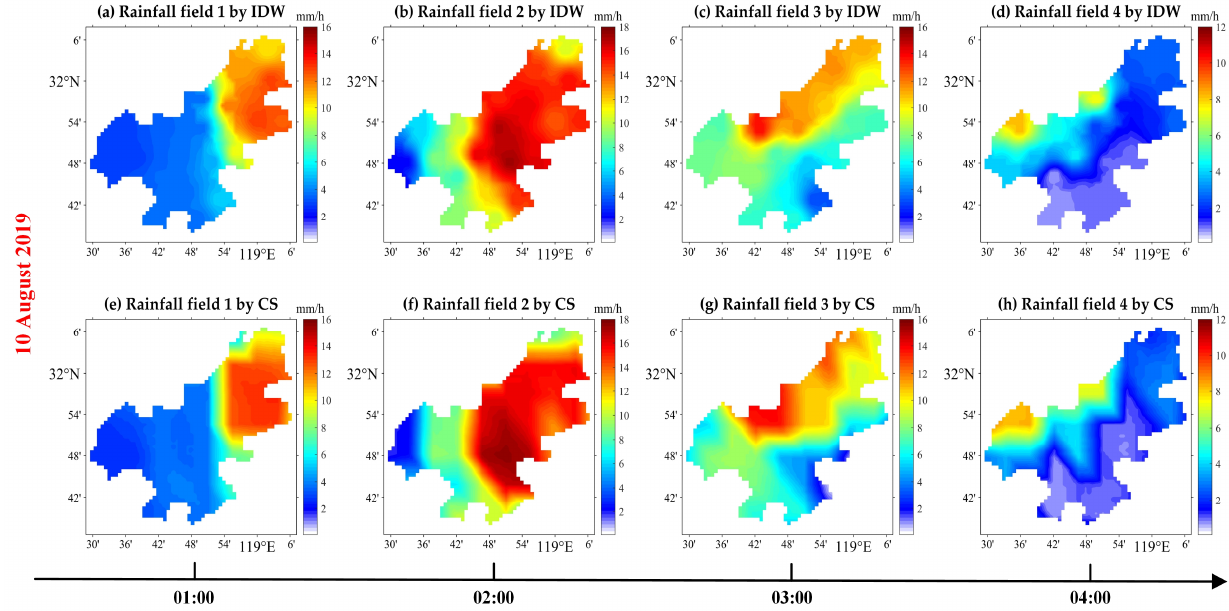
Figure 6. Results of reconstructing the rainfall fields of the rainfall event with ESL network 1 for the case of systematic noise. ( a – d ) represent the rainfall fields reconstructed by the IDW algorithm, and ( e – h ) represent the rainfall fields reconstructed by CS.